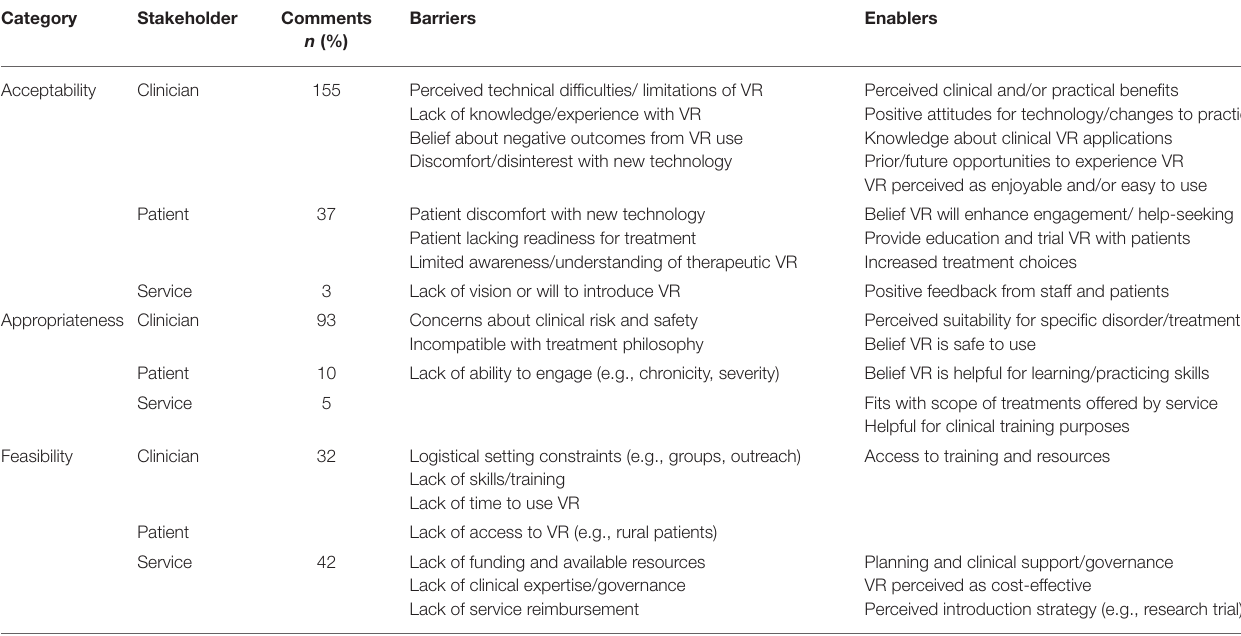
TABLE 5 | Perceived implementation barriers and enablers organized by stakeholder